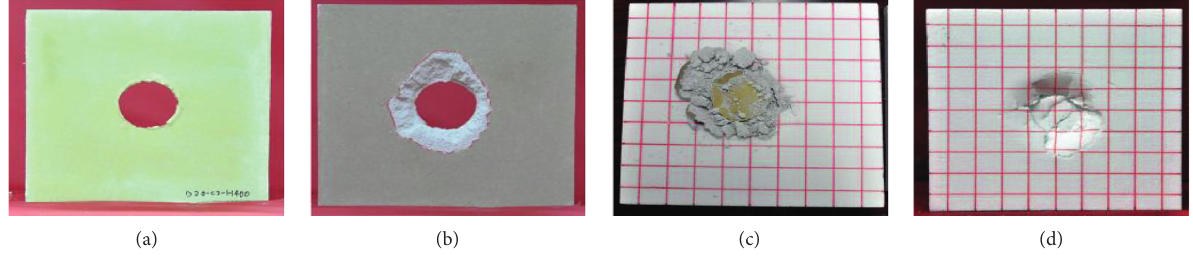
Figure 13: Damage state of the core slab and expanded material of the C-ST-H400 specimen after experiment. (a) Core slab surface. (b) Bottom surface of the slab. (c) Foam material surface after removing the slab. (d) Penetration condition of foam